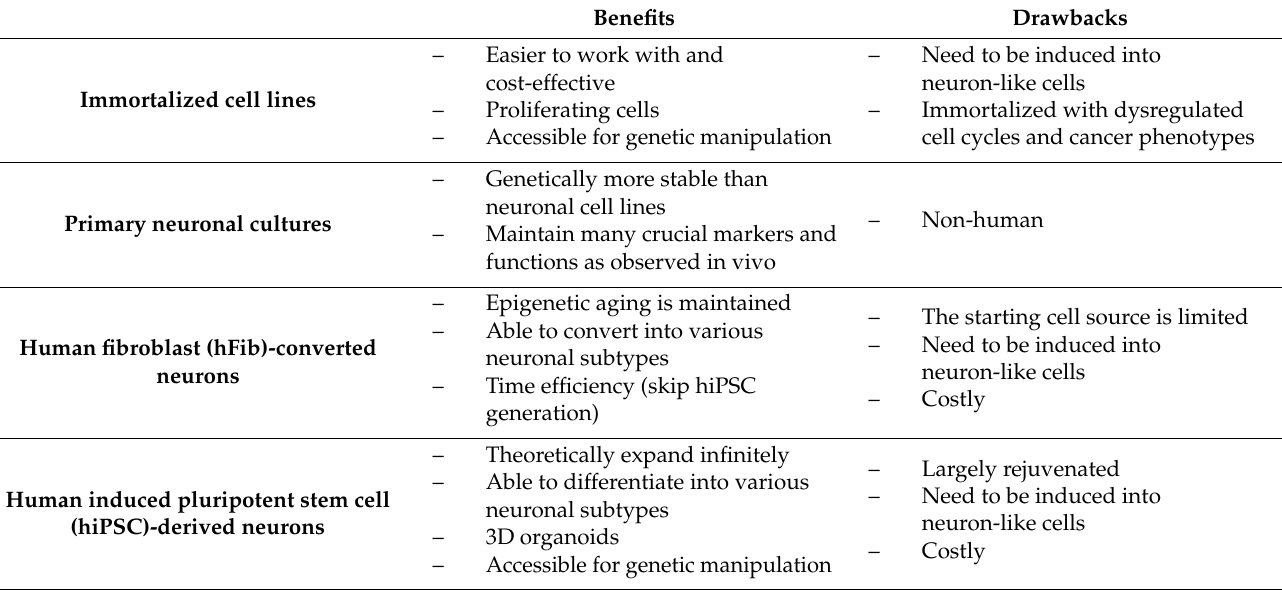
Table 2. The advantages and disadvantages of the various in vitro cell models used to study neuronal